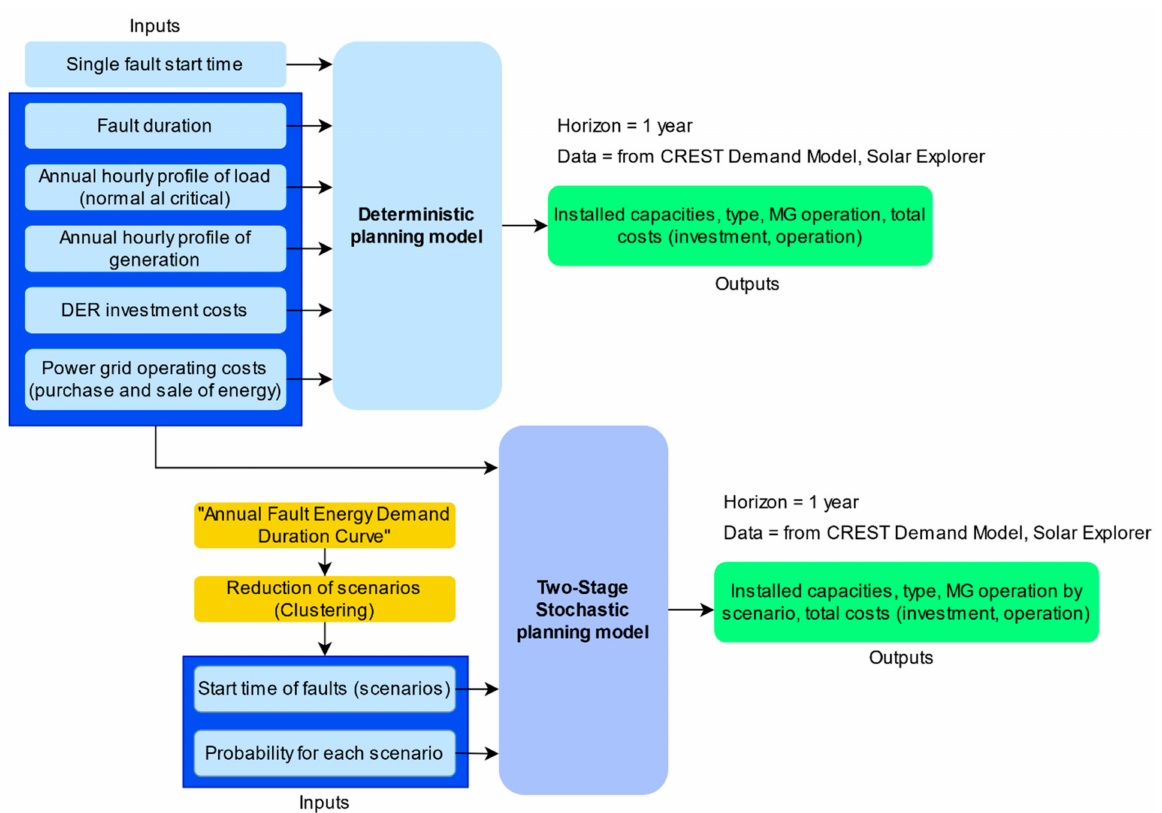
Figure 1. Graphical description of the proposed planning models for urban community microgrids with reliability